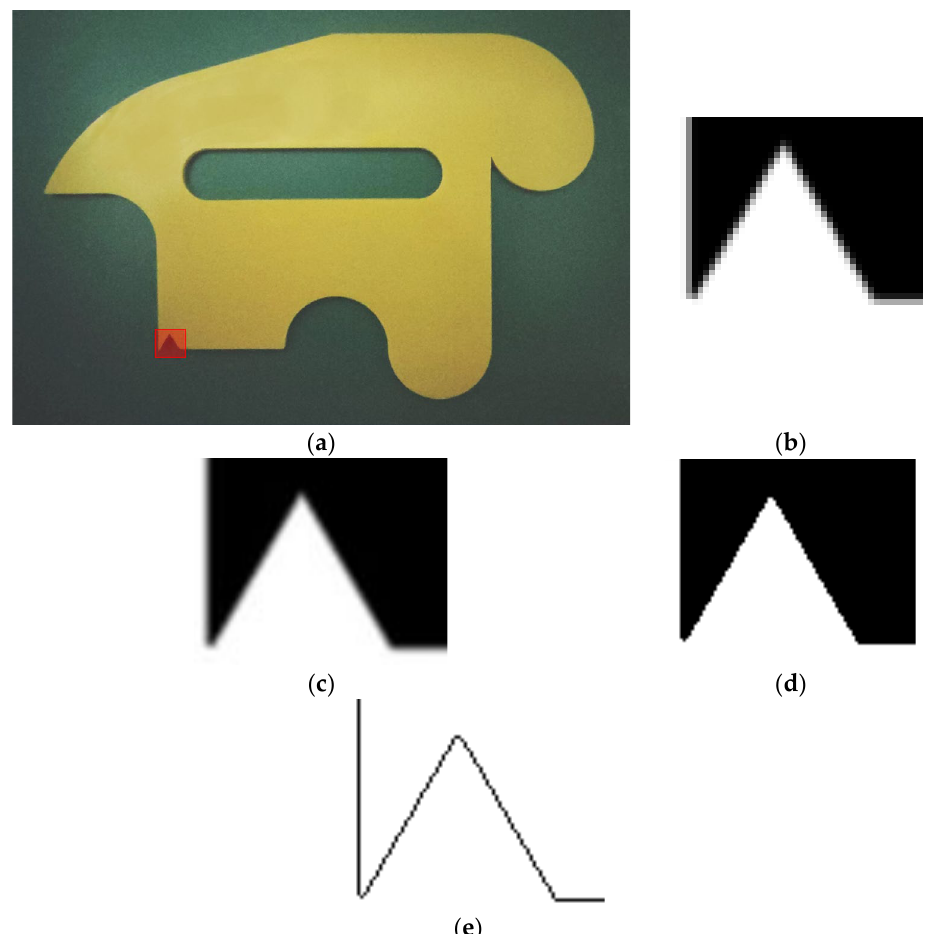
Figure 3. Image preprocessing. ( a ) Part image; ( b ) Grayscale image; ( c ) Bicubic interpolation; ( d ) Otsu binarization ; ( e ) Single-pixel contours.